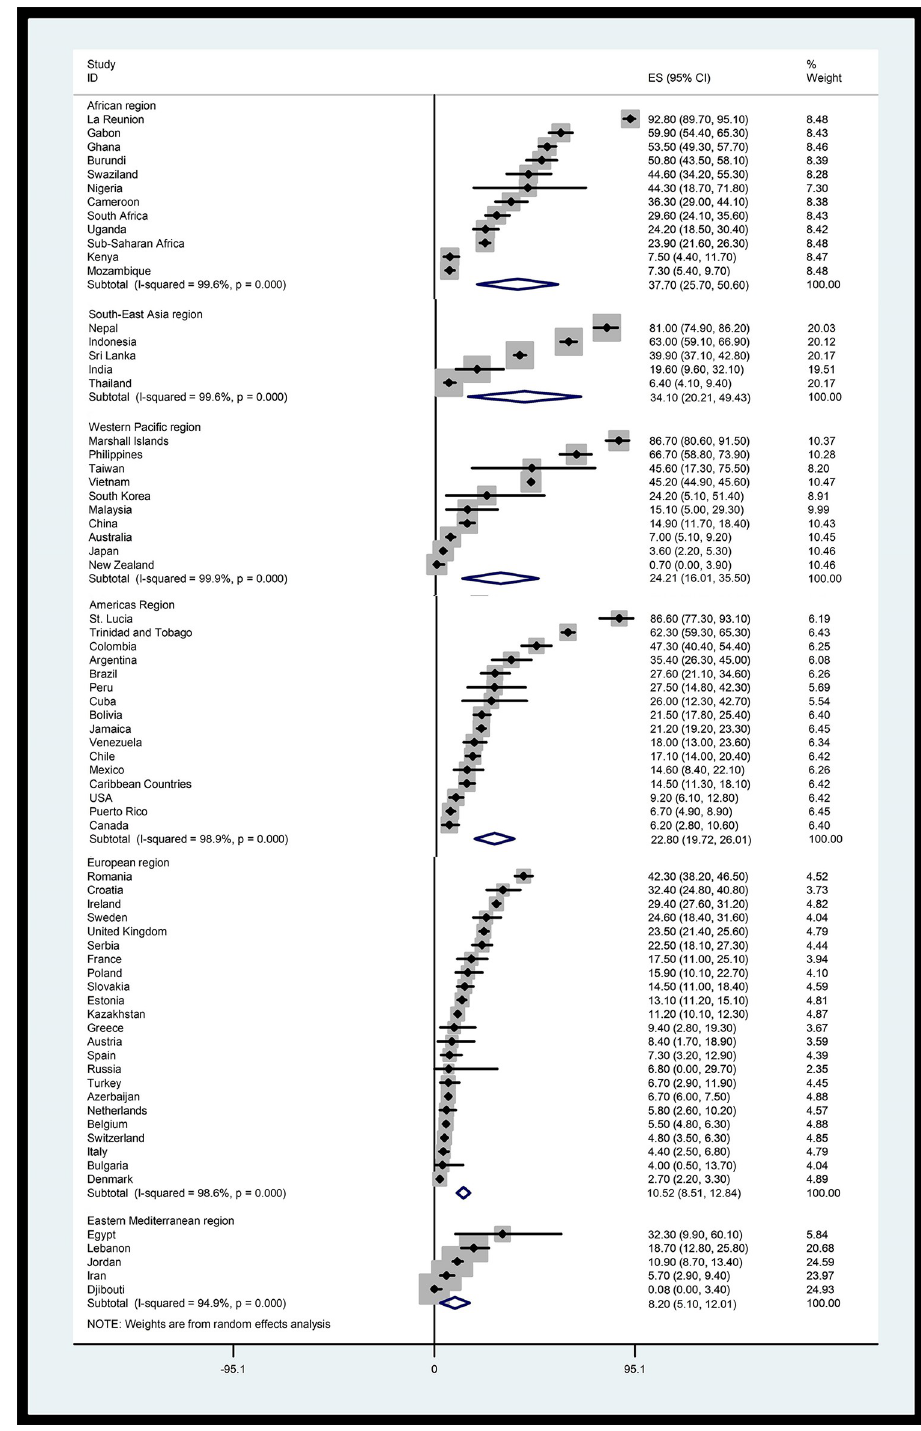
Fig 2. Forest plot of the T -seroprevalence by WHO-region and globally. ES: estimated T -seroprevalence for WHO- regions and individual countries.